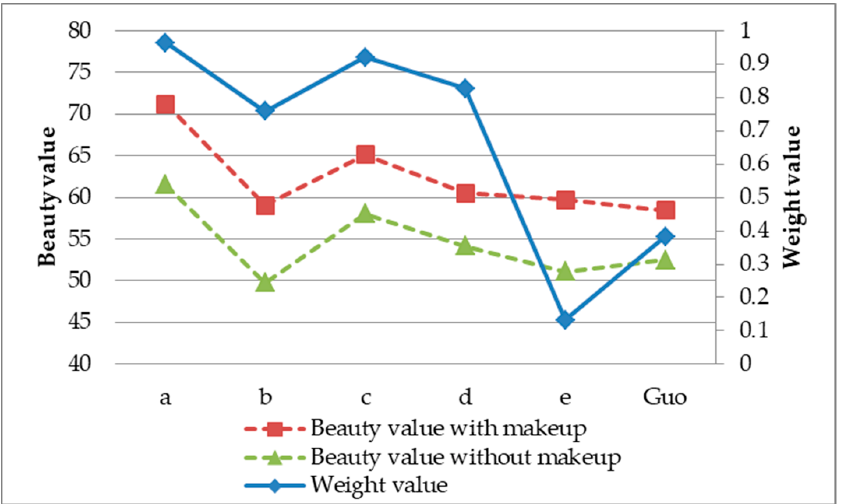
Figure 7. Different girls wear the same makeup.